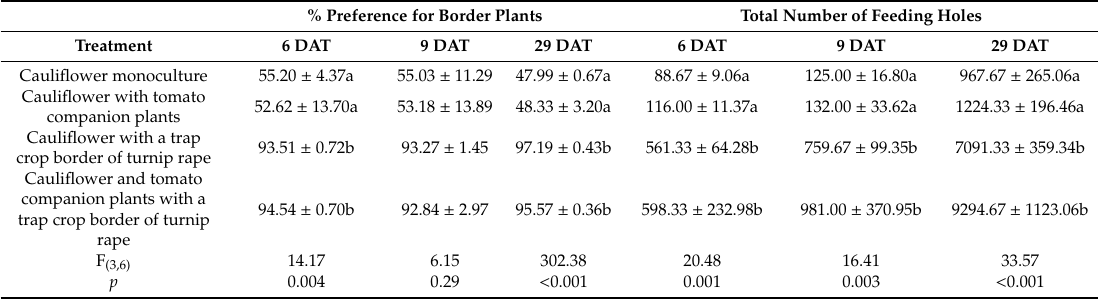
Table 4. Mean percentage feeding preference for border plants and total number of feeding holes in both border and ‘inner’ plants. Means are displayed with ± SEs. n = 3 for all means. Means with di ff erent letters (a–b) denote significant di ff erences between treatments within a column. % Preference for Border